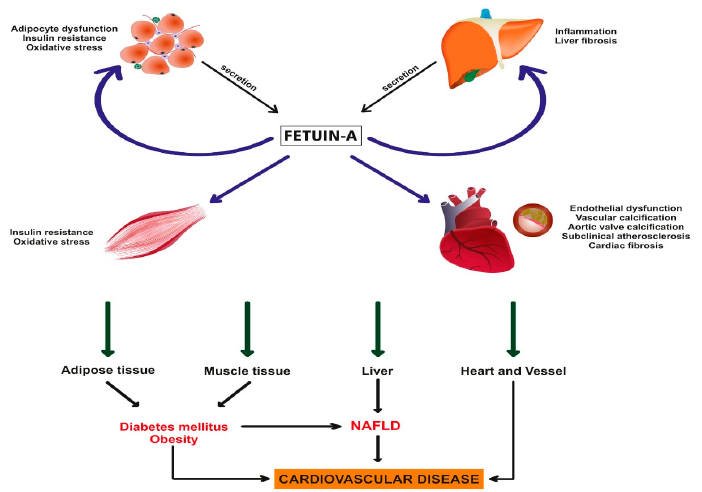
Figure 1. The pathophysiological relationship of fetuin-A with NAFLD and CVD. Increased fetuin-A in plasma exerts an insulin pathway inhibitory effect by modulating the kinase reaction on the insulin-receptor tyrosine kinase; it leads to the development of insulin resistance in insulin-sensitive tissues (muscle tissue, adipose tissue, liver, etc.) Furthermore, fetuin-A stimulates the release of inflammatory cytokines through Toll-like receptor 4 (TLR4) and it causes systemic inflammation. On the other hand, fetuin-A is an important calcium- and phosphate-binding protein and decreased fetuin-A levels strongly correlate with excessive vascular calcification and heart failure. As a result, fetuin-A protein shows a multifunctional effect in the MetS and it plays a key role in the pathogenesis of NAFLD, T2D, obesity and